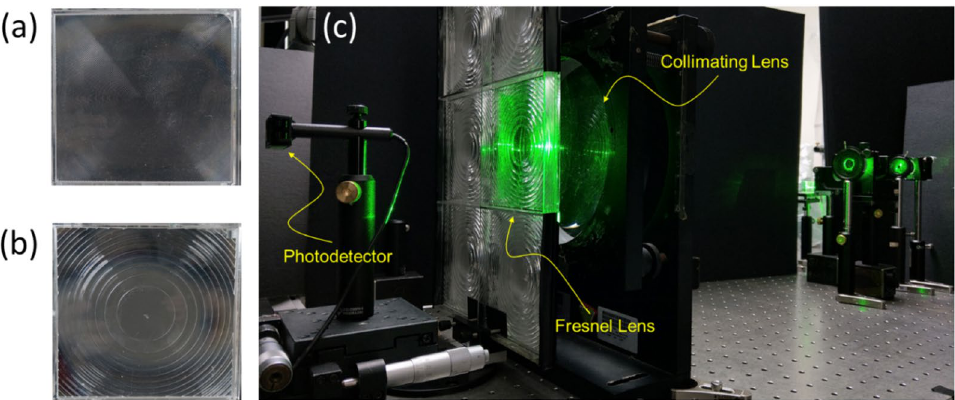
Figure 2. Light leakage measurements of the Fresnel lenses in the lab. ( a ) The thinner Fresnel lens (Fresnel lens #1): 60 main segments with a thickness of 0.56 mm. ( b ) The thicker Fresnel lens (Fresnel lens #2): 9 main segments with a thickness of 1.81 mm. Both two Fresnel lenses have the same radius. ( c ) The wavelength of light irradiation is 532 nm, and the power is around 100 mW. With the collimation lens, the light beam fully covers the Fresnel